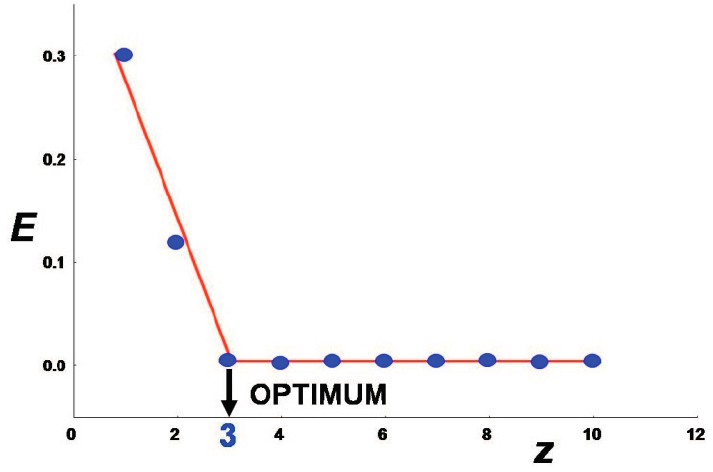
Figure 12. Plot of the sum-of-squared residuals ( E ) as a function of the number z of neurons in the first hidden layer of the network. The optimal value of z is equal to